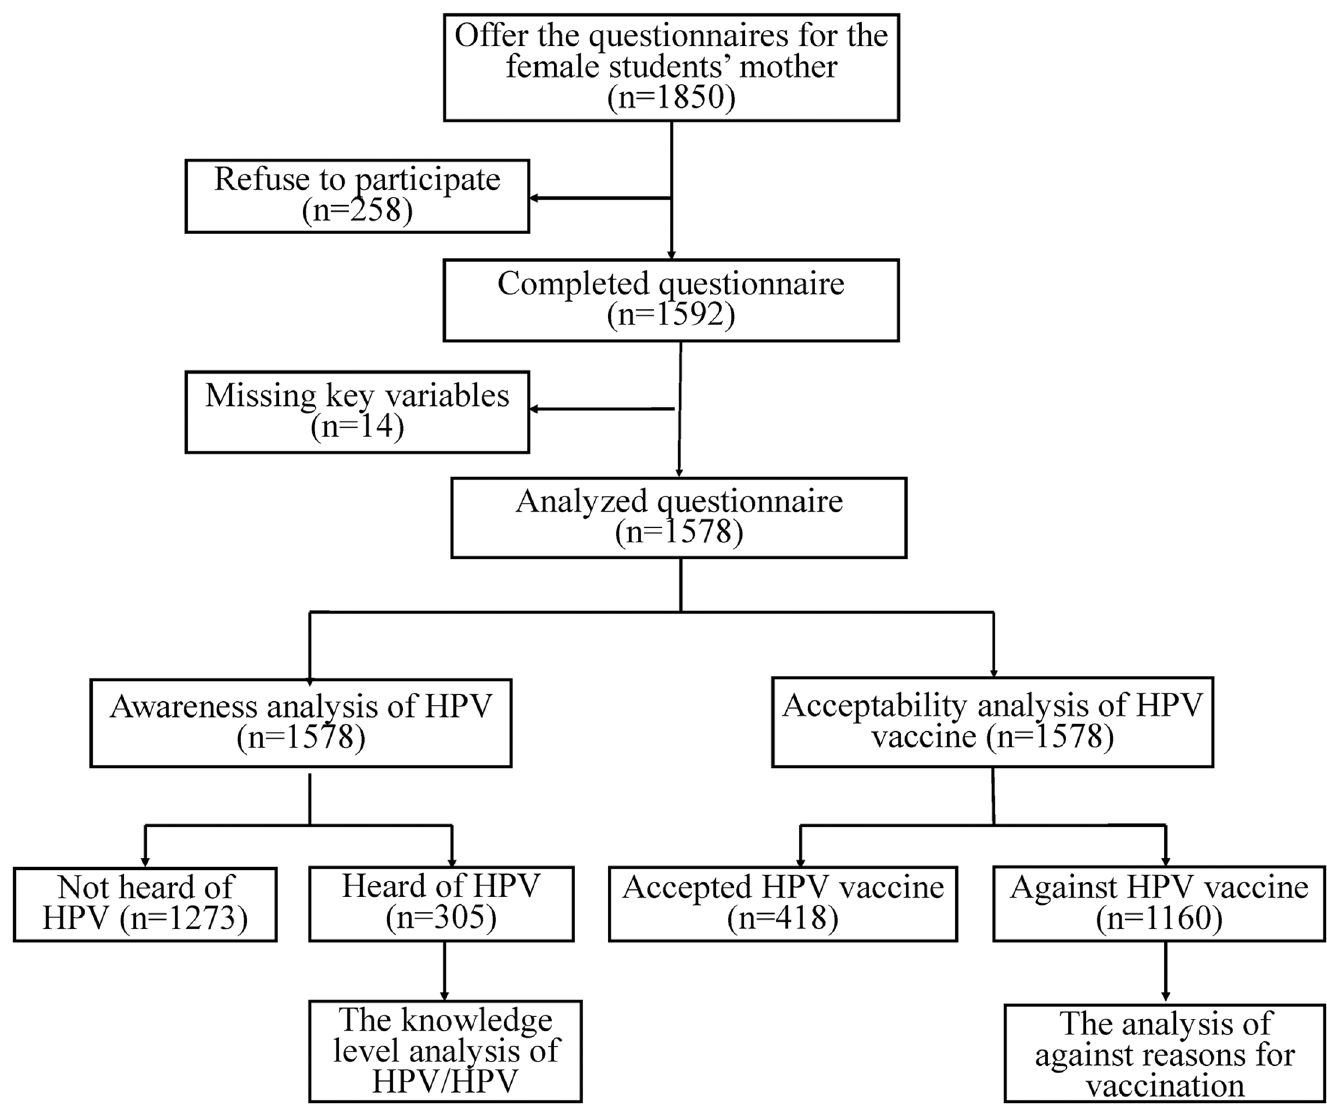
Fig 1. The Flow chart of